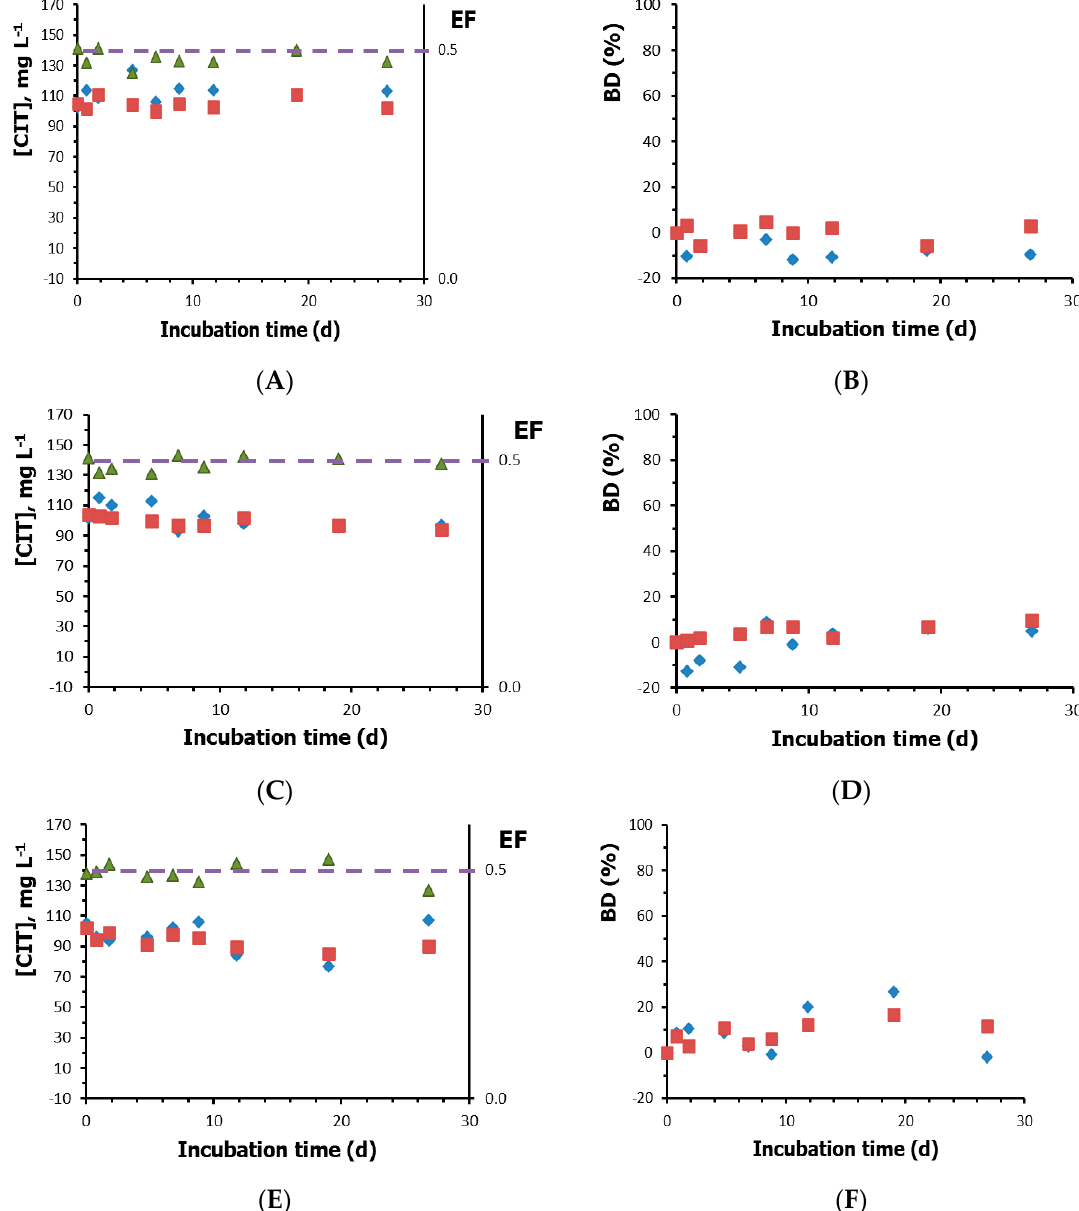
Figure 3. Estimated concentrations ( S ), biodegradation ( BD ), and enantiomeric fraction ( EF ) obtained for citalopram (CIT) in incubated samples during the biodegradability assays: ( A , B ), abiotic assay; ( C , D ), biotic assay inoculated with 1 mL of activated sludge; ( E , F ), biotic assay inoculated with 10 mL of activated sludge. S , BD and EF values correspond to the mean of two replicates. Dashed line, EF = 0.5, represents no enantioselectivity. Symbols: ( ■ ) E1 ‐ CIT; ( ◆ ) E2 ‐ CIT; ( ▲ ) EF.